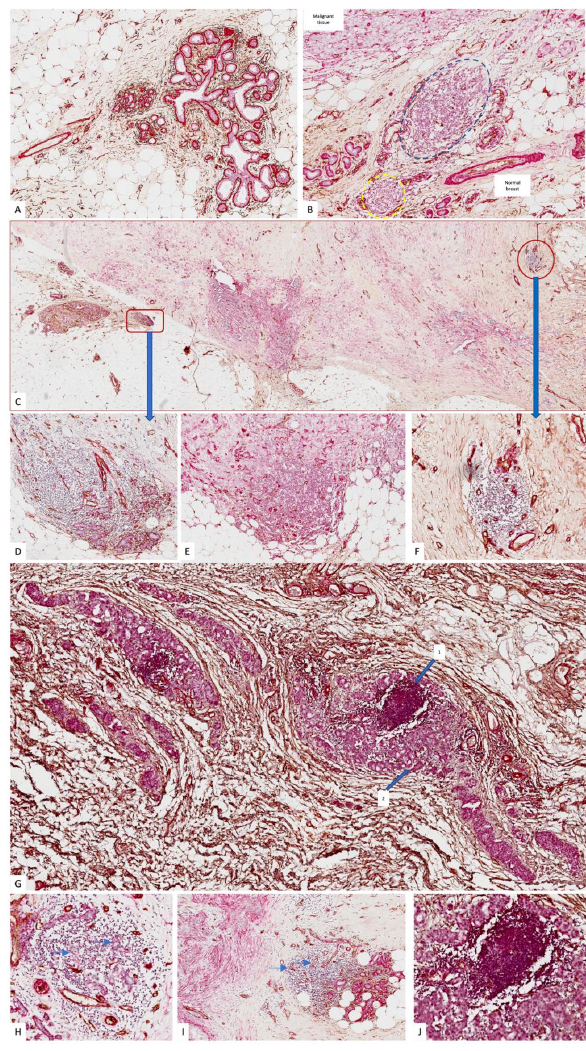
Figure 1. ( A – J ) Comparative TLS assessment distribution from normal to malignant breast cancer tissue. ( A ) No TLSs were detected inside normal breast tissue. ( B ) TLS complex interrelations with tumor tissue (upper left) but also with several TME components such as stromal blood vessels and adipose tissue. ( C ) General overview of TLS topography in mammary gland stroma related to its neighborhood with adipose tissue. ( D , E ) TLSs in direct contact with adipose tissue or ( F ) surrounded by stroma. ( G , J ) Intratumor TLSs are smaller in size (( G ), inset 1) and surrounded by tumor cells (( G ), inset 2). ( H ) Sometimes, TLSs are invaded by tumor cells (arrows) in a manner mimicking lymph node metastasis or ( I ) are highly vascularized (arrows) without any tumor cells inside. ( A – J ) Double stain for CD34 positive reaction for endothelial cells highlighted in brown with diaminobenzidine and smooth muscle actin (SMA) for perivascular cells highlighted in red with permanent AEC